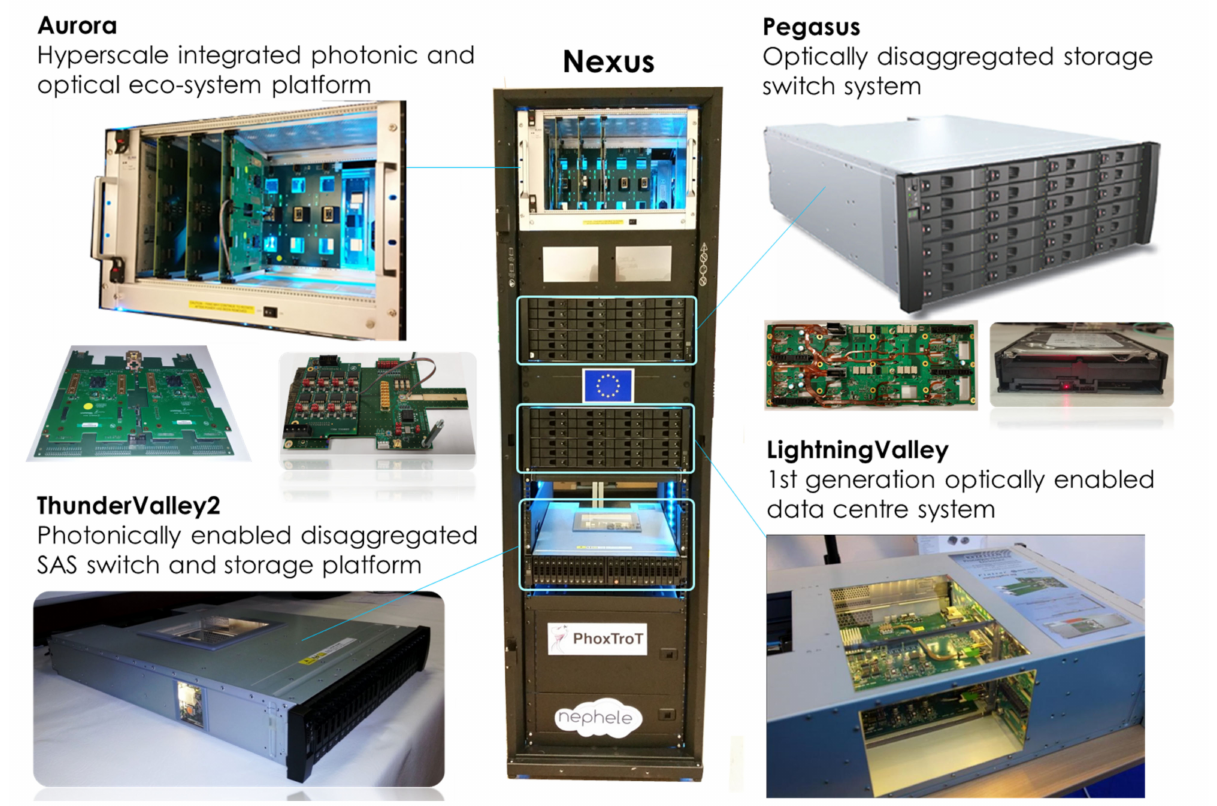
Figure 15. Converged rack-scale data center system